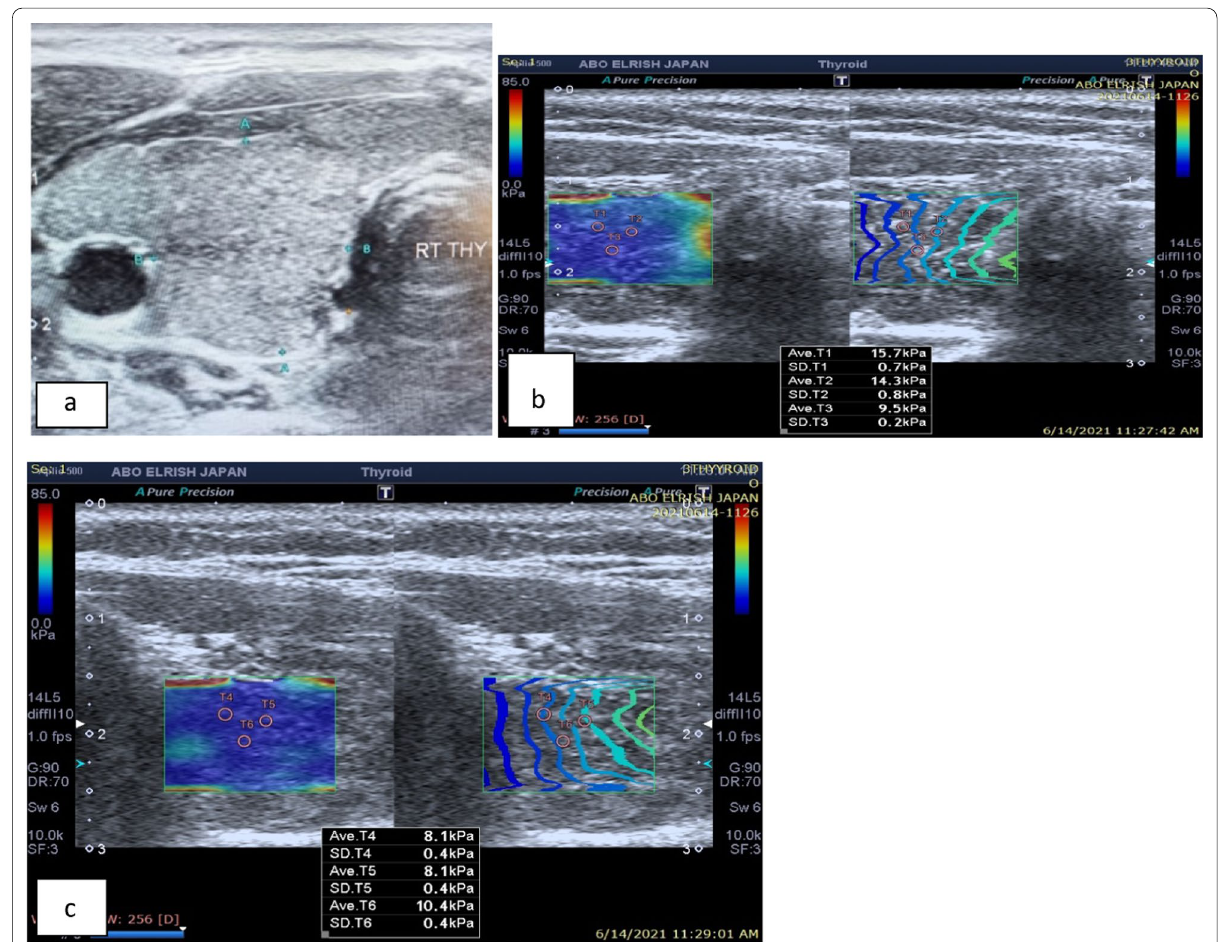
Fig. 6 a Gray scale ultrasound of the thyroid gland, in an 8-year-old female with history of Crohn’s disease and neck swelling for 2 years. TPO-Ab positive and TG-Ab borderline, diagnosed as Hashimoto’s thyroiditis. The gland is of homogeneous hyperechoic echotexture with normal dimensions of both glands and vascularity. b , c SWE of thyroid glands measuring elasticity of both thyroid glands (b) right thyroid lobe (15.7, 14.3 and 9.5 kPa) c left thyroid lobe (8.1,8.1 and 10.4 kPa)